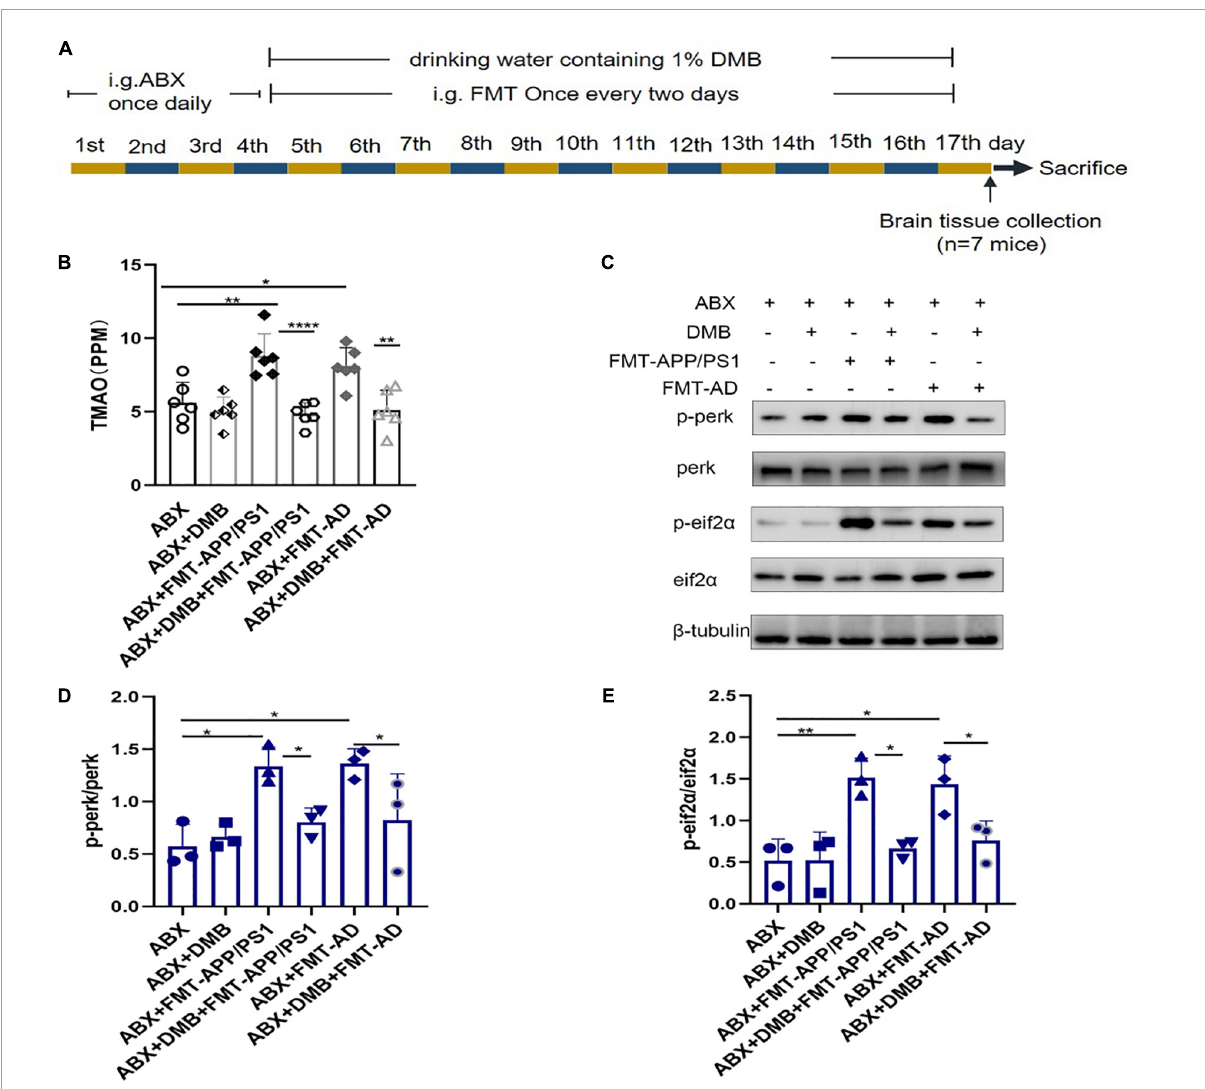
FIGURE4 Trimethylamine-N-oxide (TMAO) inhibition with DMB reversed endoplasmic reticulum (ER) stress in the cerebral cortex. (A) Experimental design of DMB-treated mice. (B) Serum TMAO levels after DMB treatment. (C–E) . Representative immunoblots on day 17 of the experiment showed p-perk and p-eif2a levels in the cerebral cortex. P < 0.05 was set as the threshold for significance by one-way ANOVA followed by post-hoc comparisons using LSD’s test for multiple groups’ comparisons, * p < 0.05, ** p < 0.01, and **** p <